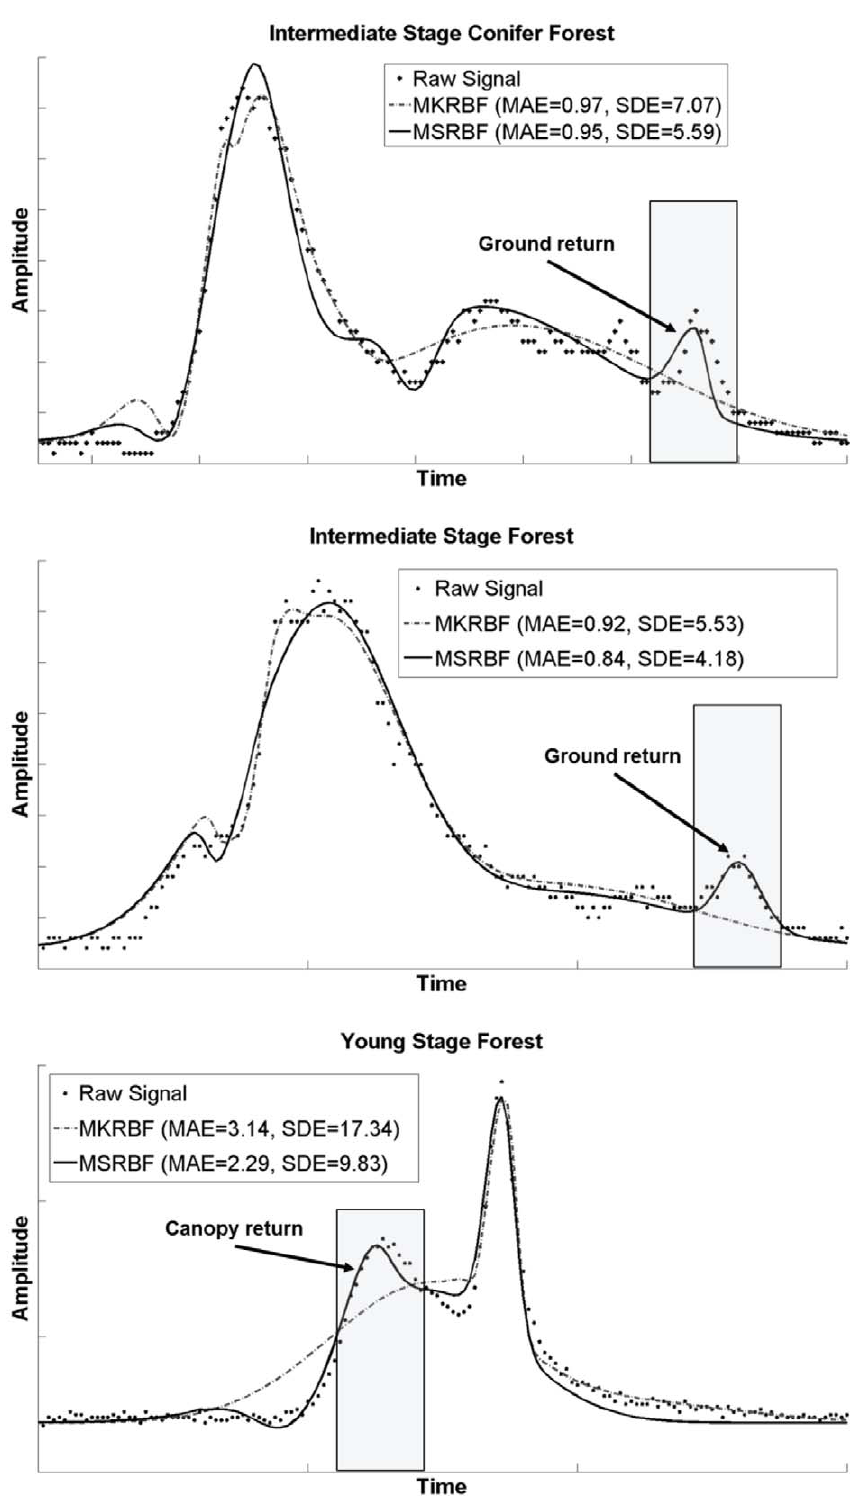
Figure 9. Contrasting MK and MS RBF fitting capabilities for biophysical feature extraction.